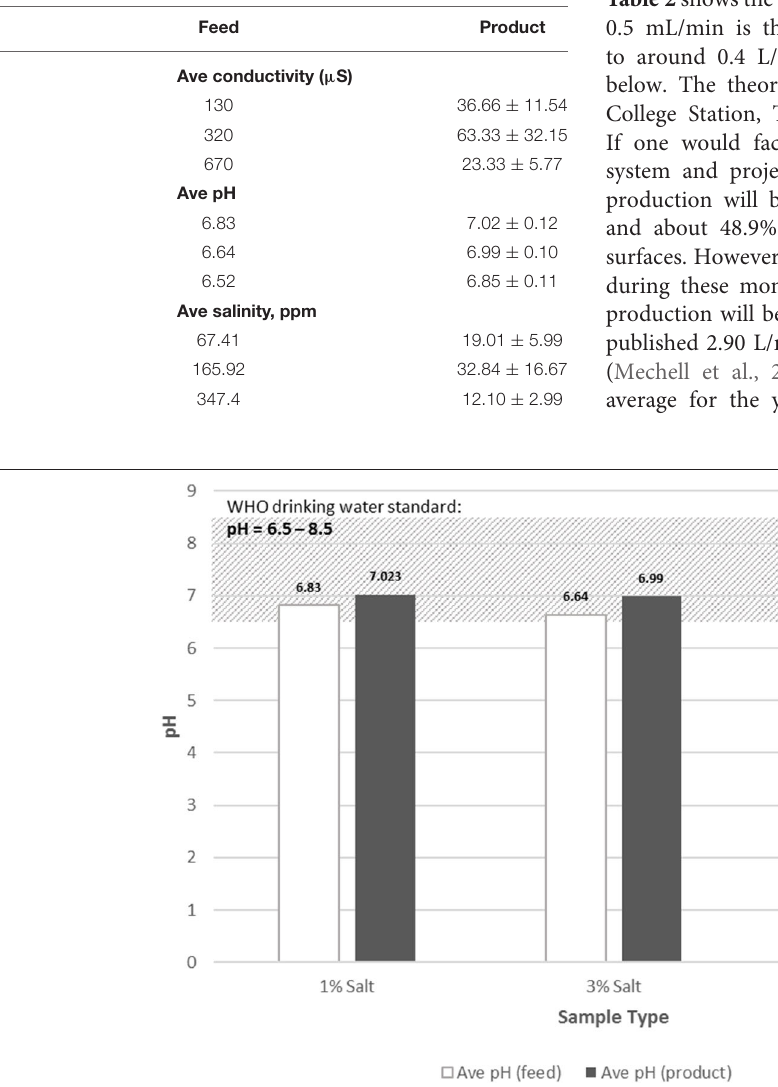
TABLE 1 | Average water quality data.